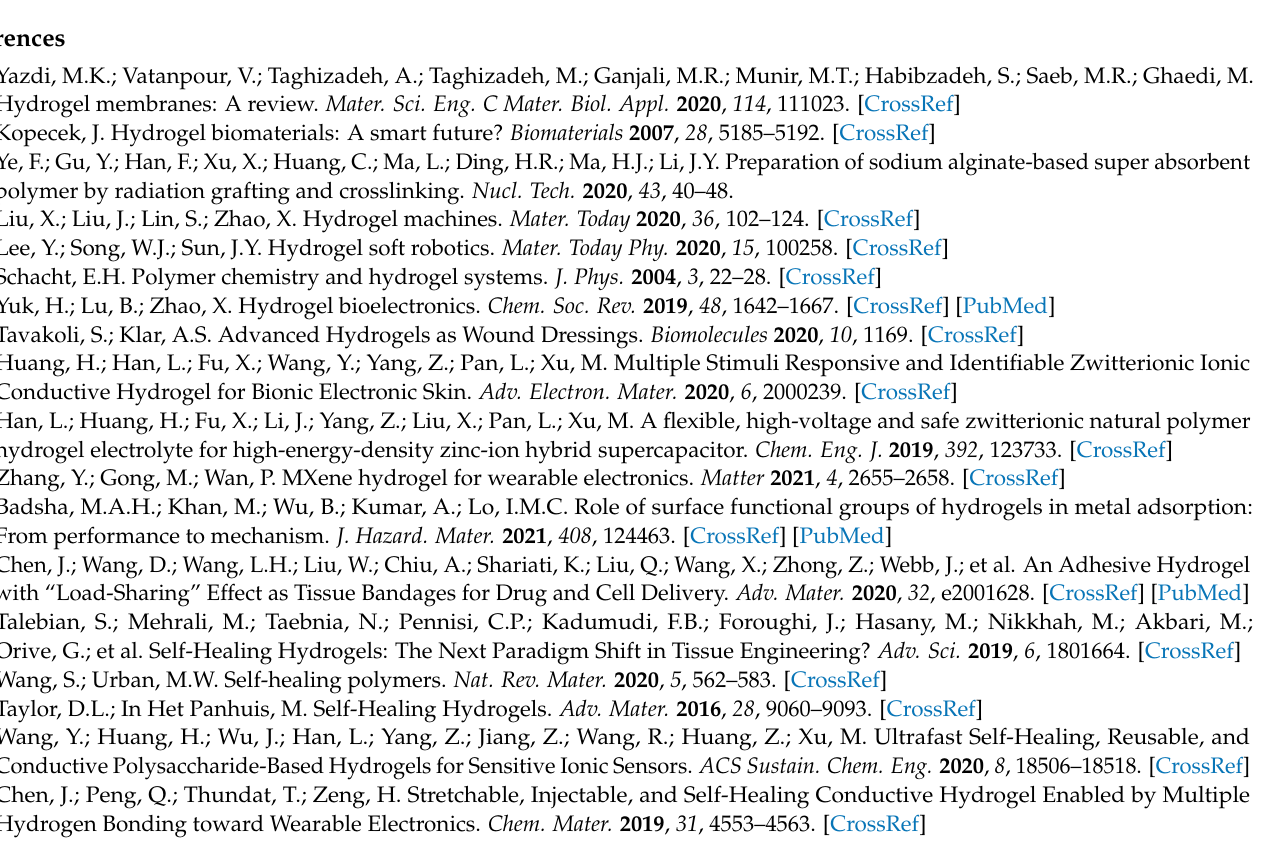
Table S2: Mechanical properties of CMA hydrogels; Table S3: Comparisons of self-healing ability of CMA-3 hydrogel with previous reported self-healing hydrogel in the literature; Figure S1: Comparisons of Young modulus of CMA-3 hydrogel with previous reported self-healing hydrogel in the literature; Figure S2: Compressing-recovering process of CMA-3 hydrogel; Figure S3: Water retaining ability of CMA-3 hydrogel; Figure S4: Tensile stress–strain curves of CMA-3 hydrogel during the self- healing process at different healing time ( A,B ); Figure S5: Photographs of self-healing ability of CMA-3